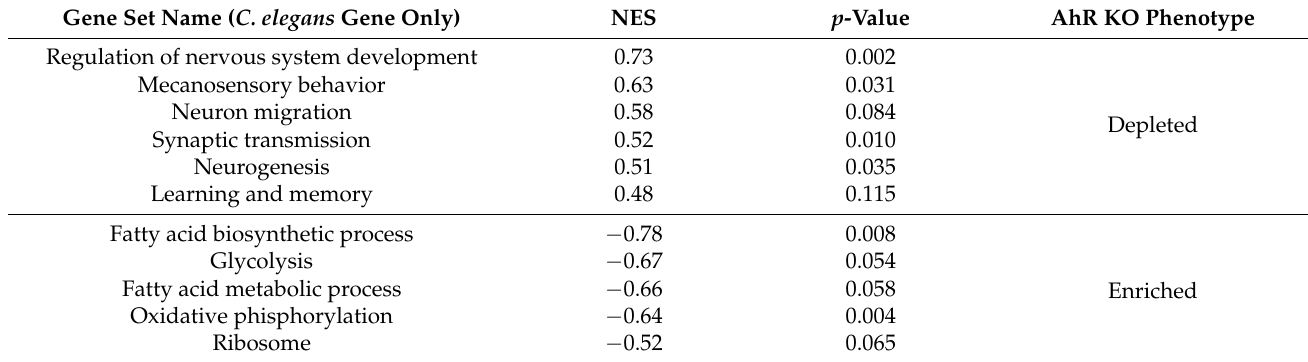
Table 2. Gene set enrichment analysis of ahr-1 mutant vs. WT phenotypes. GSEA shows the highest depleted and enriched gene sets in ahr-1 mutant phenotype in comparison to the wild type one. NES: normal enrichment score. Gene sets are GO terms or from https://www.gsea-msigdb.org (accessed on 20 May